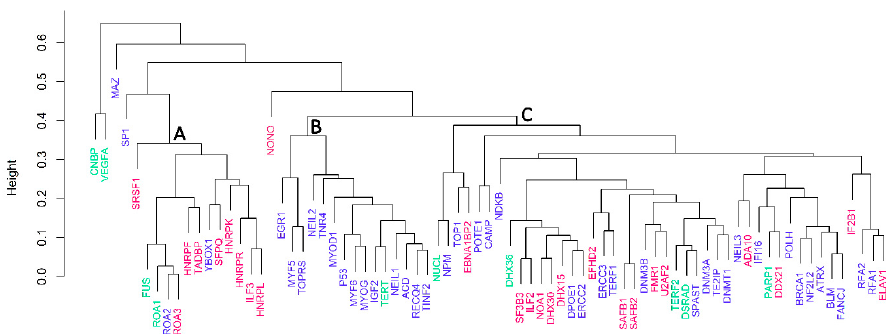
Figure 3. Cluster dendrogram of 77 quadruplex binding proteins based on their amino acid compositions constructed using R package pvclust and bootstrap resampling (n = 10,000) with average cluster method. For precise cluster determination, AU values equal to or greater than 95 were chosen as cut-off criterion; the three resulting main clusters (A,B,C) are marked. Protein symbols are highlighted either in red (only RNA quadruplex binding), in blue (only DNA quadruplex binding), or in green (both RNA and DNA quadruplex binding).